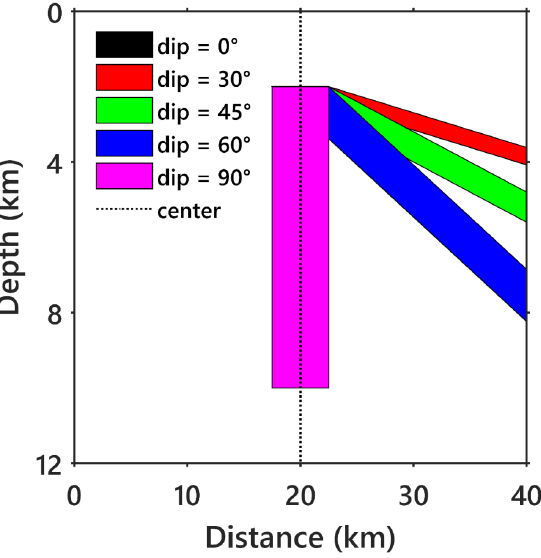
Figure 1. Schematic diagram representing the buried dyke at different dipping angles.